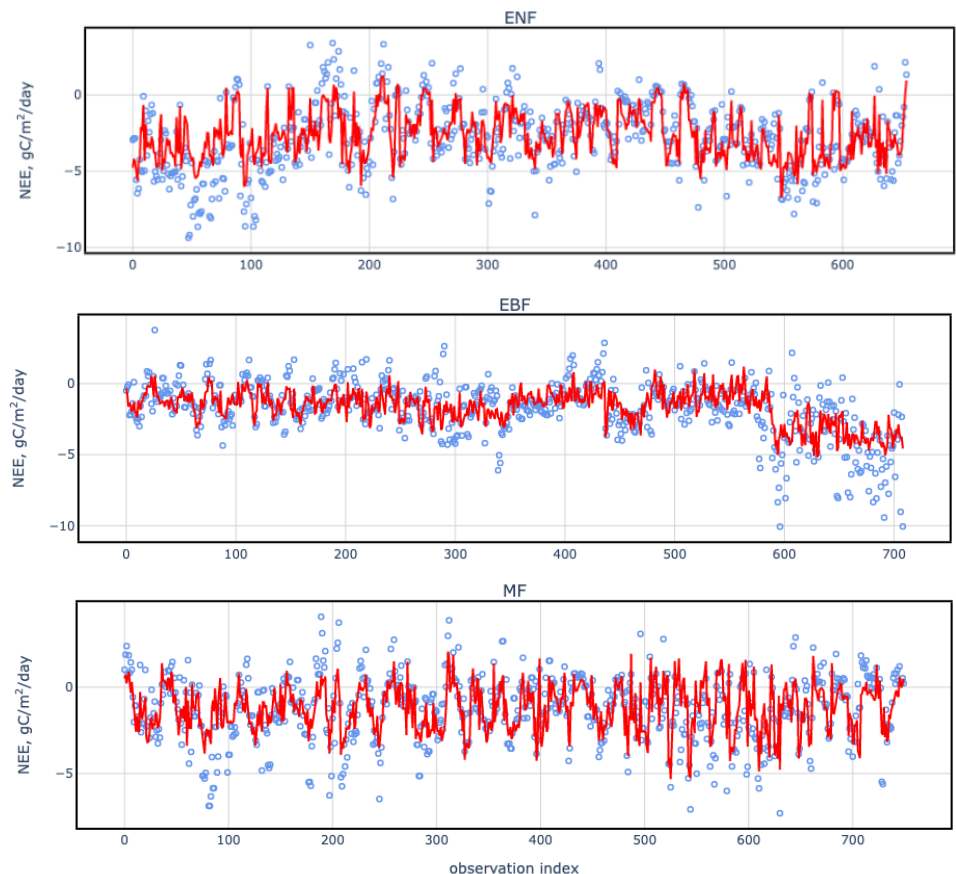
Figure 5. Time series of observed NEE and the predicted NEE based on remote sensing and meteoro- logical features models per each land cover: cropland (CRO); grassland (GRA); evergreen needleleaf forest (ENF); deciduous broadleaf forest (DBF); evergreen broadleaf forest (EBF); mixed forest (MF); wetland (WET); savanna